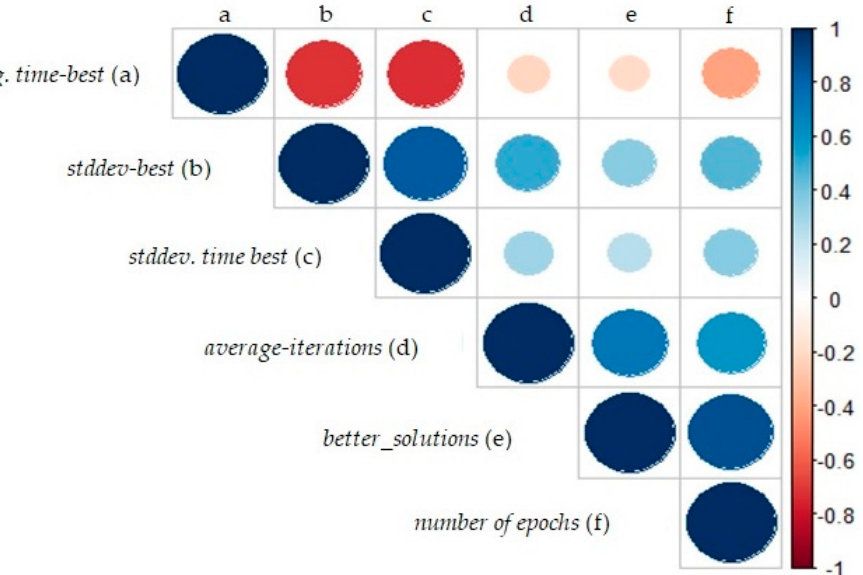
Figure 1. Correlogram of the time-performance metrics: avg.time-best, stddev-best, stddev.time best, average-iterations, better_solutions and number of epochs for average-iterations, better_solutions and number of epochs for d2103.